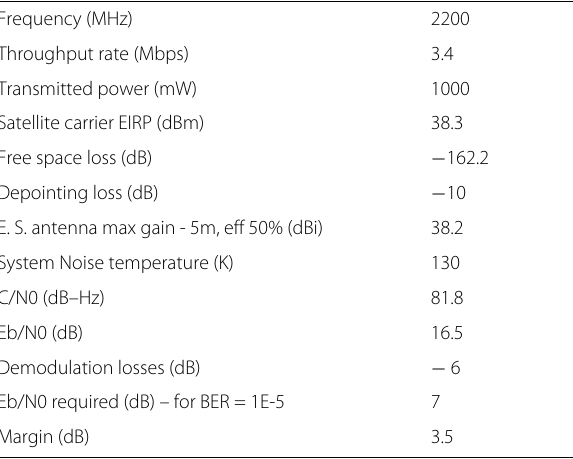
Table 1 Primary user link budget (QPSK coded FEC R =